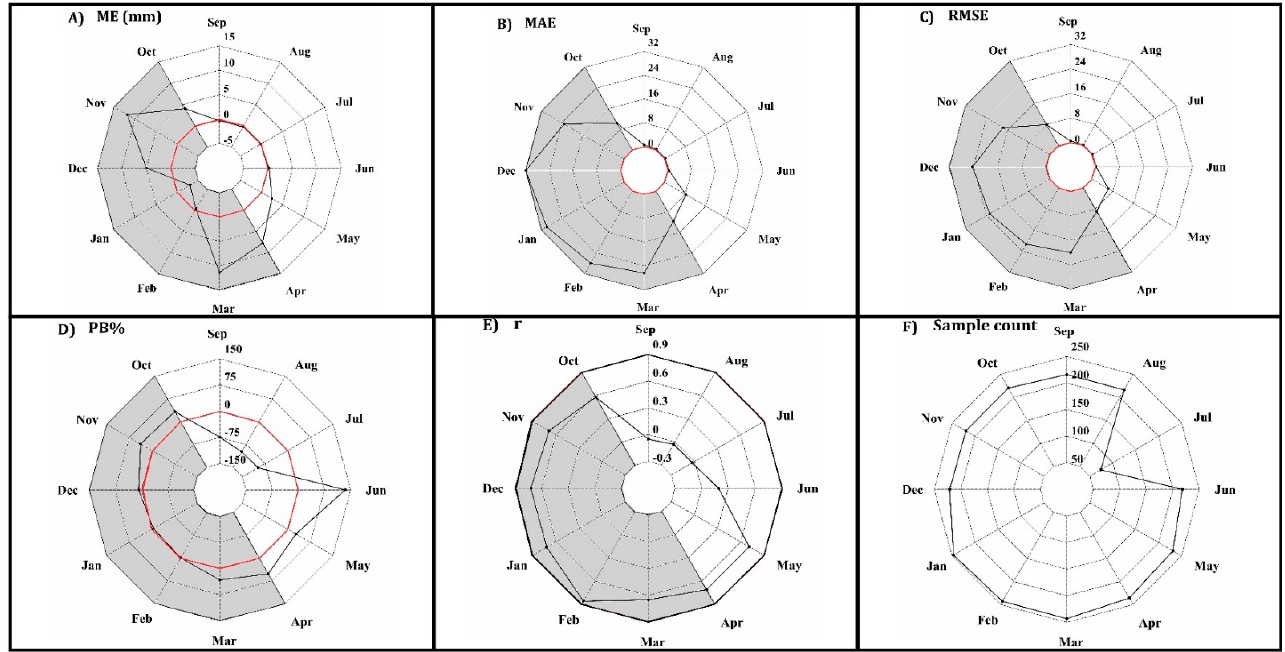
Figure 6. Shows results of the accuracy statistics ( A ) ME, ( B ) MAE, ( C ) RMSE, ( D ) PB%, and ( E ) r . The comparison is between CHIRPS estimates to the in-situ dataset for each month in the Barada Basin from 2000 to 2020. Red lines indicate the optimal values. Grey highlighting indicates the rainy season. In ( E ), for better visualization of r values, we made the upper limit 0.9 (the optimal value of r is 1) as all r values were under 0.8. ( F ) Represent the sample count at every month that used to calculate the monthly accuracy